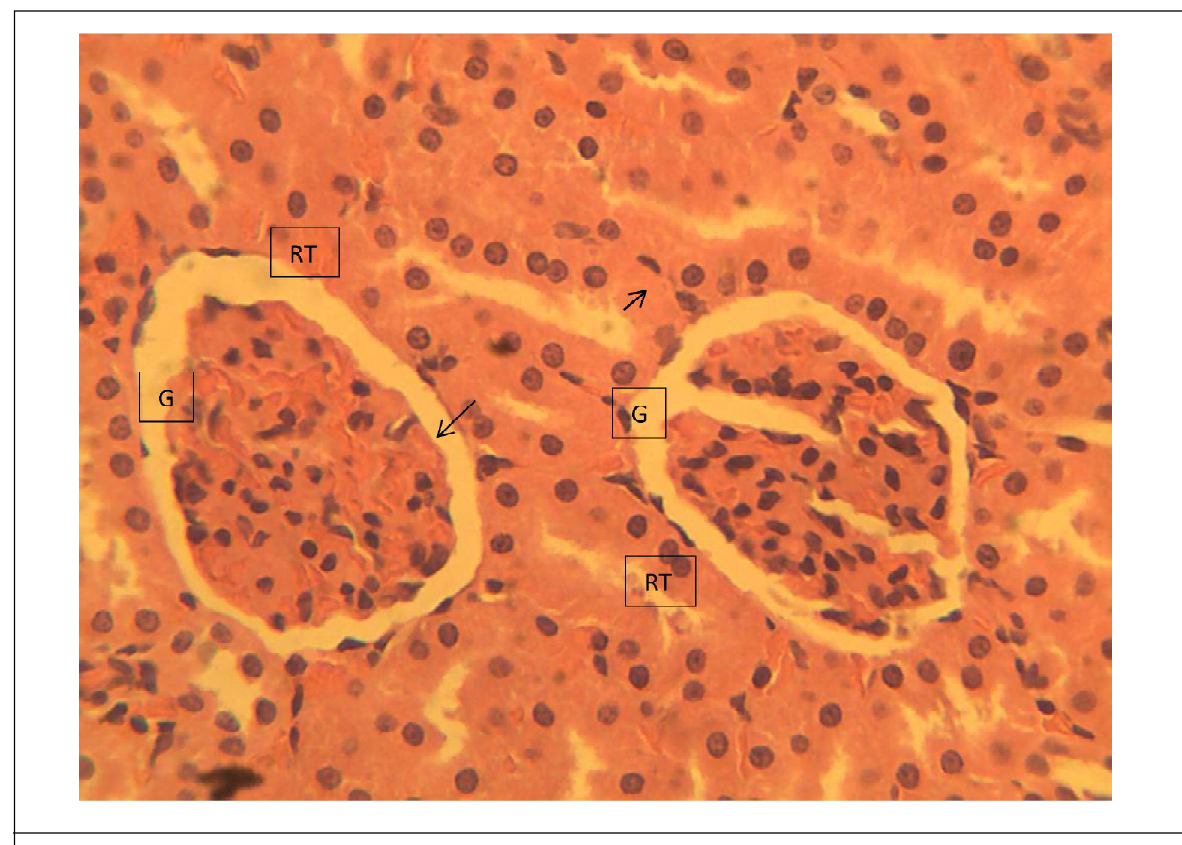
Plate 20: Female kidney of the group exposed to 800 mg/kg of methanol